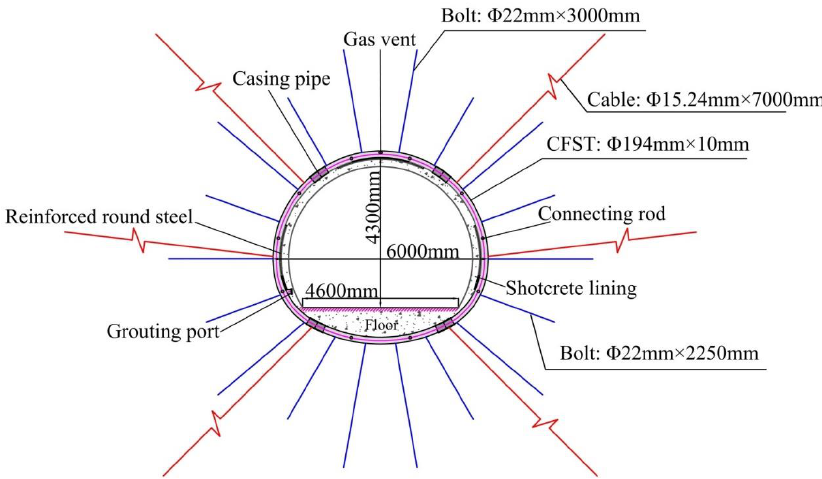
Figure 12. New support scheme layout.